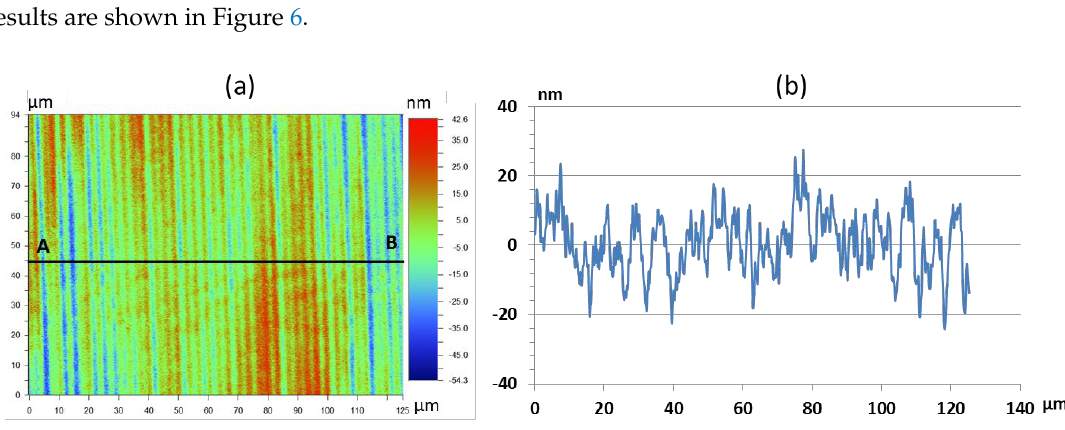
Figure 6. ( a ) WLI Surface measurement of the mold insert after the fly-cutting process, ( b ) extracted 2D-profile along AB.